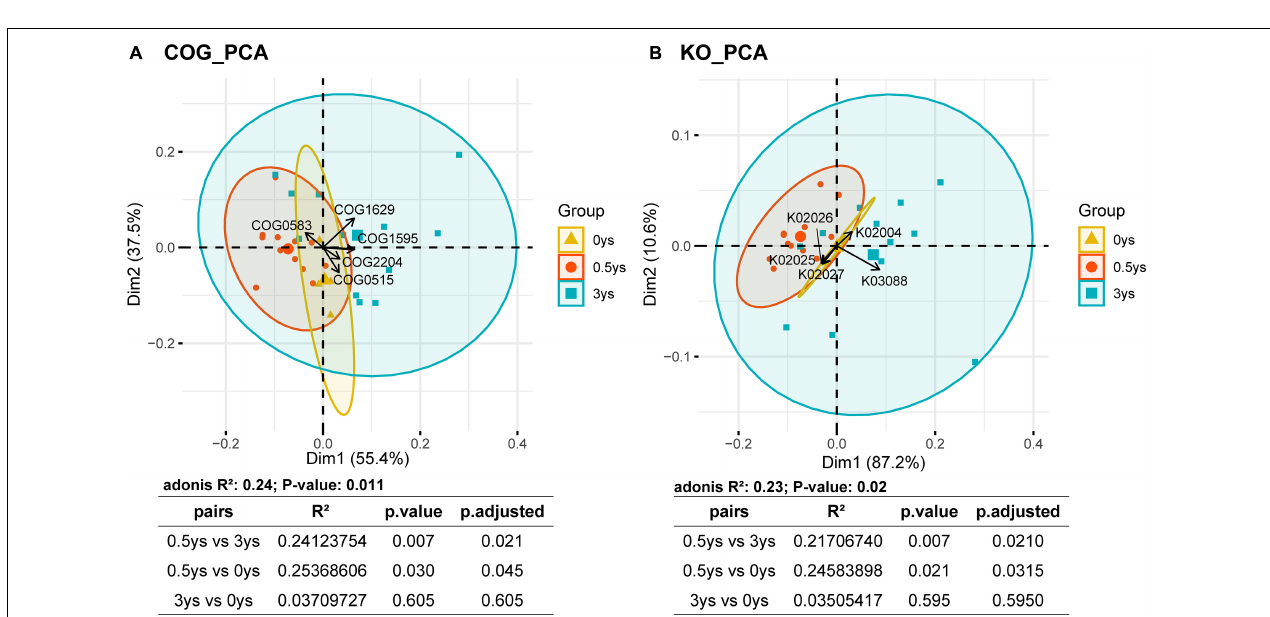
FIGURE 7 | Principal component analysis based on COG (A) and KEGG (B) functional annotations. The arrows represent the most volatile COG and KEGG classifiers in the functional prediction results. PERMANOVA was used to test the significance of the differences.